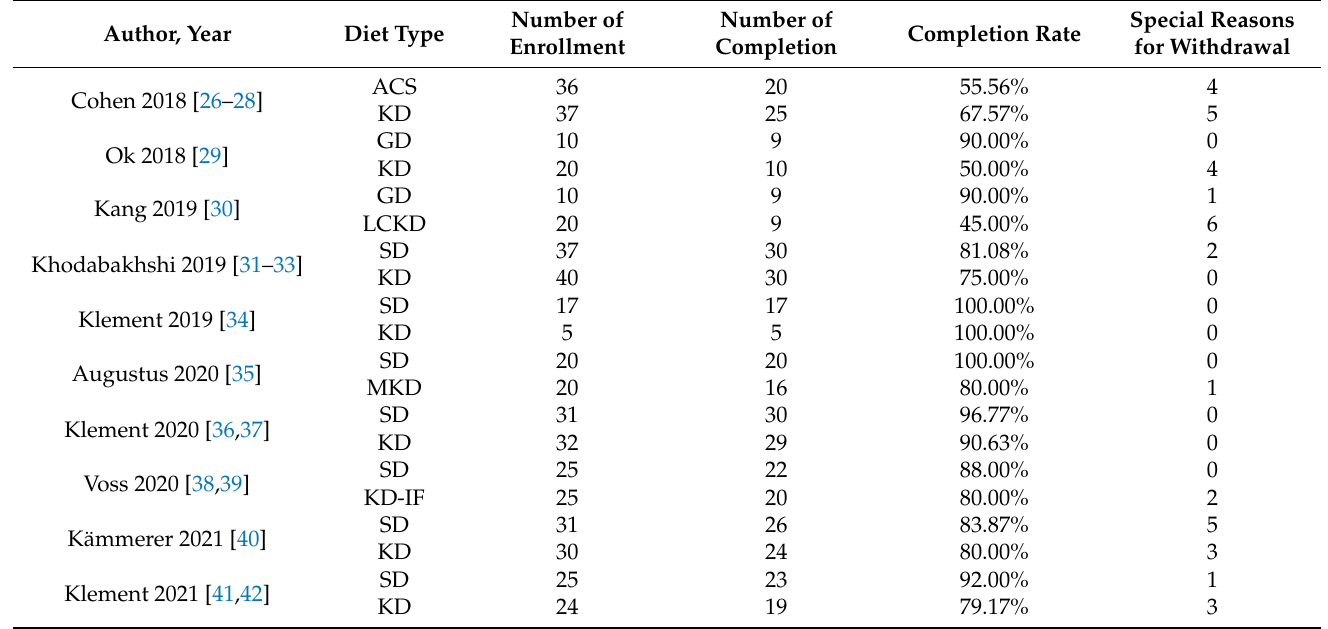
Table 1. Completion rate of